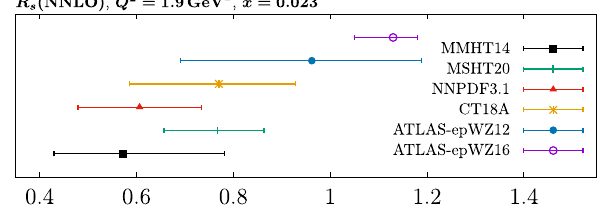
Fig. 30 Comparison of the value of R s at x = 0 . 023 and Q 2 = 1 . 9 GeV 2 for a range of NNLO PDF